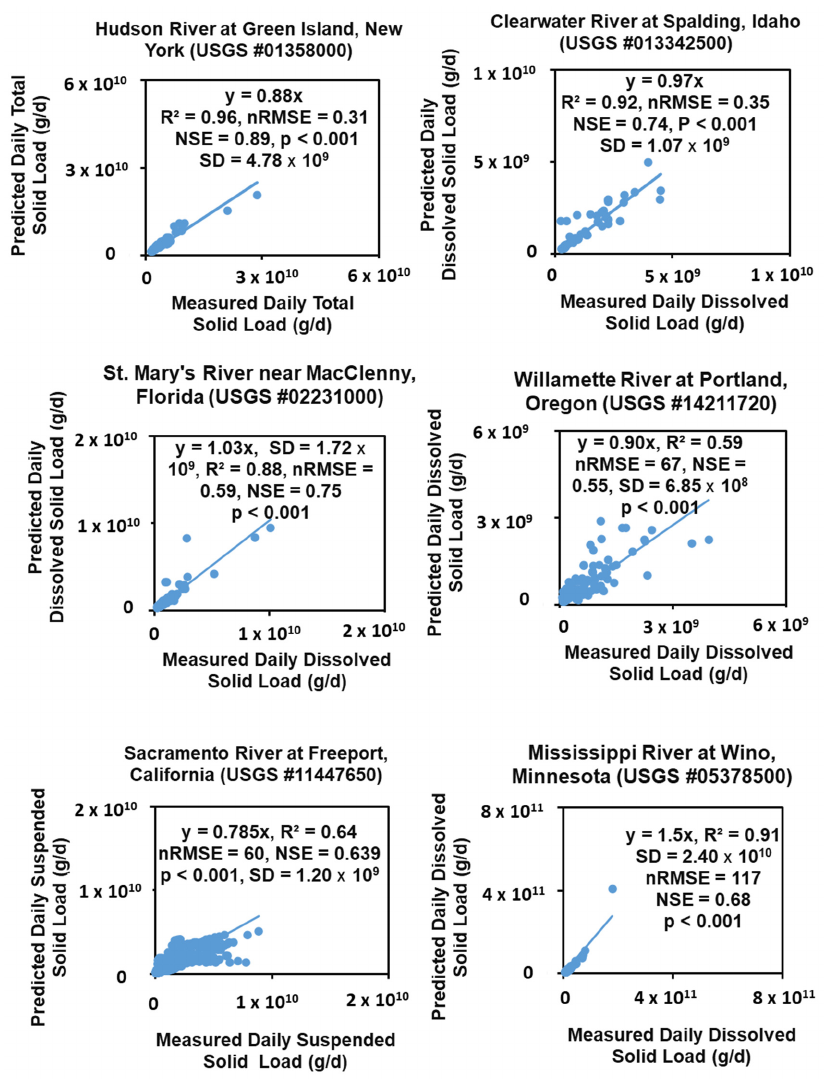
Figure 3. Comparisons of the daily sediment loads between the method predictions and the field measurements for the six USGS stations.